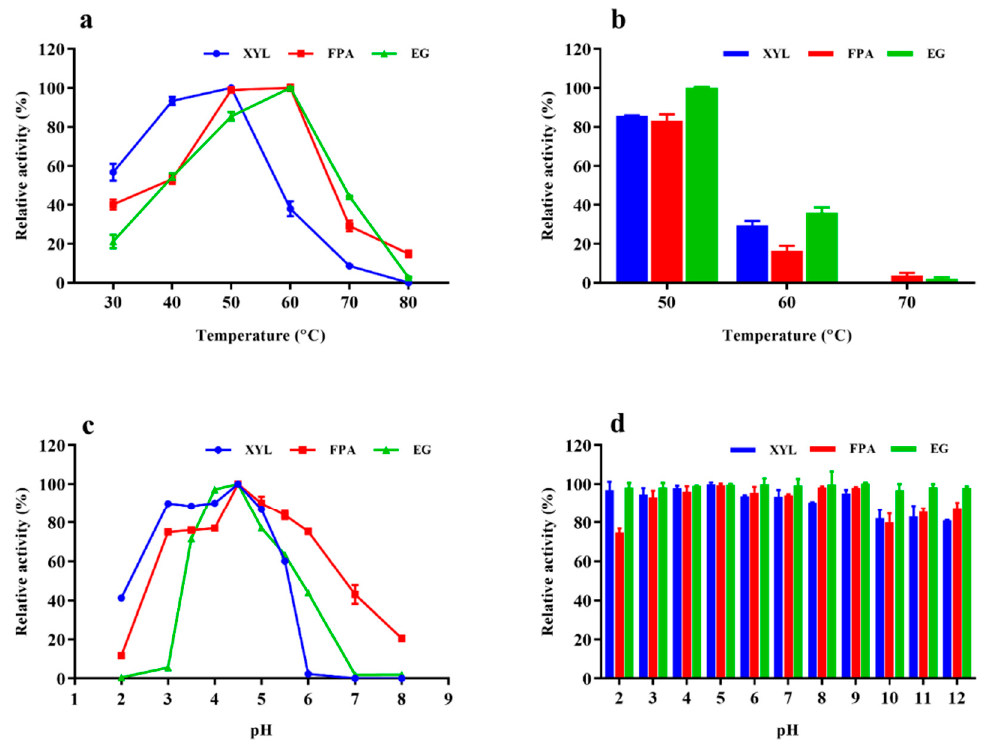
Figure 4. Characterization of FPA, CMCase, and xylanase of T. harzianum EM0925 enzyme cocktail. ( a ) The e ff ect of temperatrure on FPA, CMCase, and xylanase of T. harzianum EM0925 enzyme cocktail; ( b ) thermostability of FPA, CMCase, and xylanase of T. harzianum EM0925 enzyme cocktail; ( c ) the e ff ect of pH on FPA, CMCase, and xylanase of T. harzianum EM0925 enzyme cocktail; ( d ) pH stability of FPA, CMCase, and xylanase of T. harzianum EM0925 enzyme cocktail. pH stability was determined by measuring the residual activity after incubation of T. harzianum EM0925 enzyme cocktail in di ff erent bu ff ers for 1 h. The relative activity was determined, and the maximum activity was defined as 100% ( a , c ). The initial activity of T. harzianum EM0925 enzyme cocktail not pre-incubated in di ff erent bu ff ers was defined as 100% ( b , d ). Values are the mean of three replicates ± SD. Int. J. Mol. Sci. 2020 , 21 , x 8 of 18